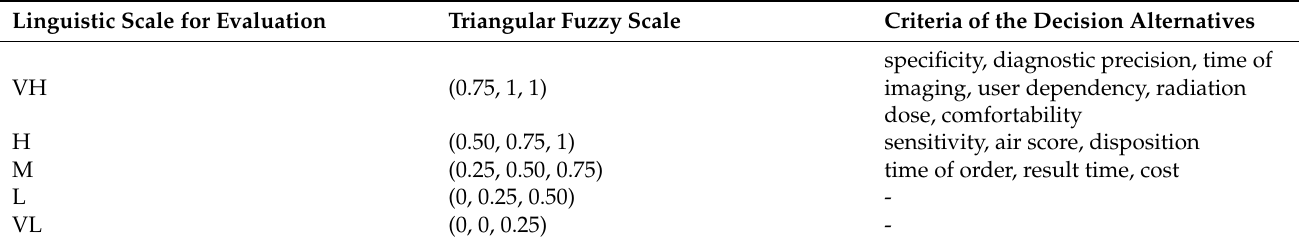
Table 2. Linguistic fuzzy